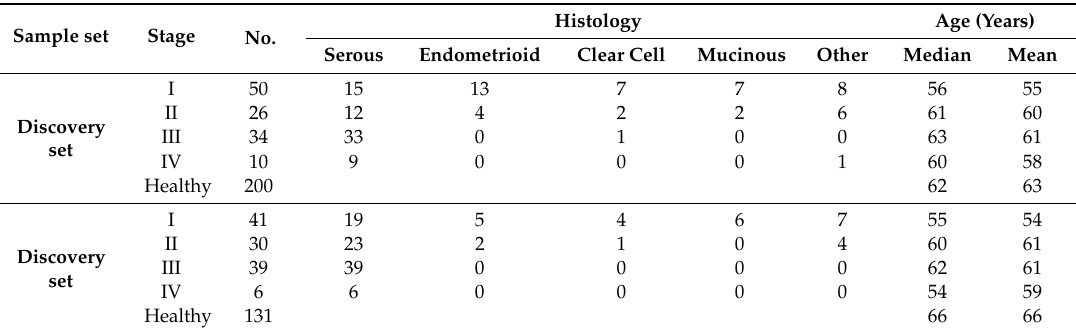
Table 1. Characteristics of the patient